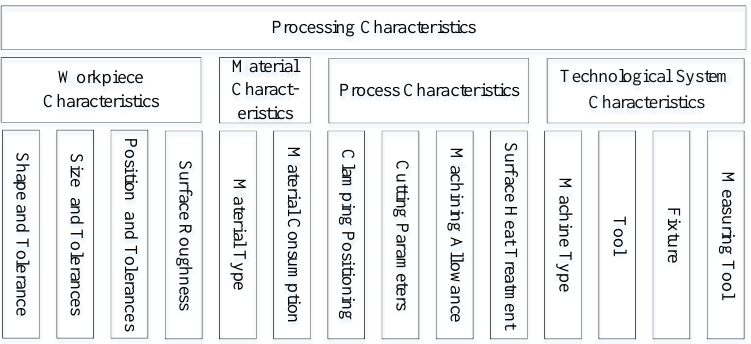
Figure 4. Machining characteristics of parts.